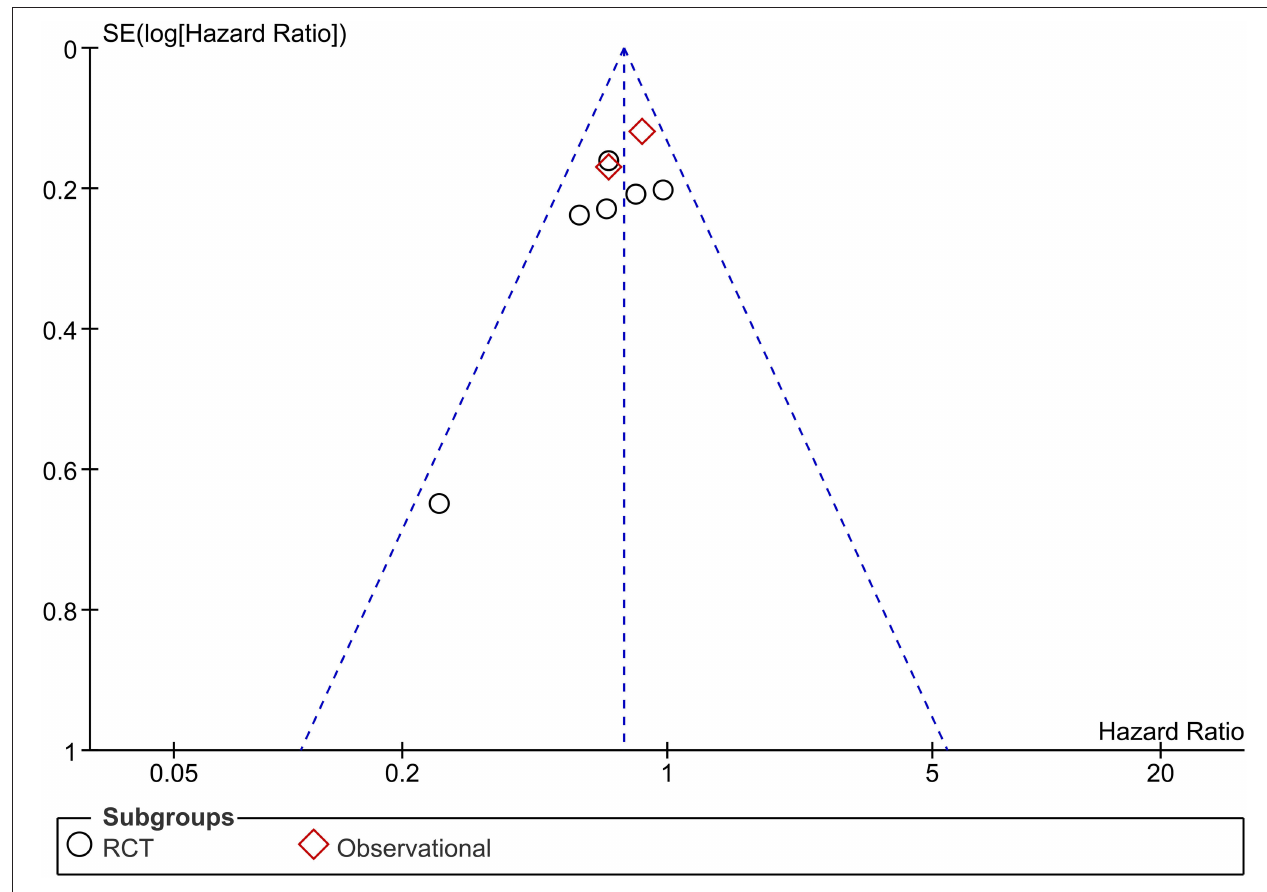
FIGURE 5 | Funnel-plot